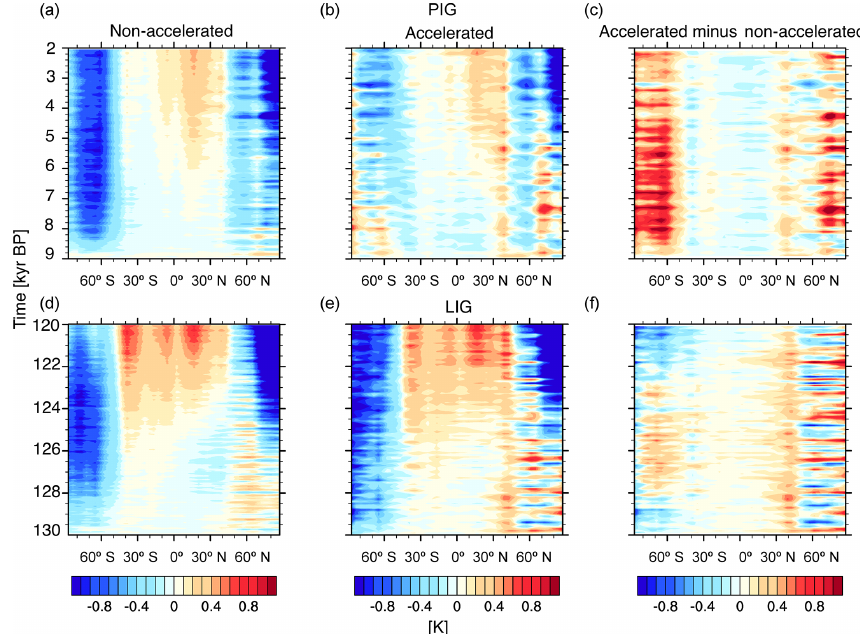
Figure 3. Evolution of zonally averaged surface temperature anomalies (including ocean and land) during interglacials for both non- accelerated (a, d) and accelerated (b, e) simulations. Shown are anomalies relative to 9kyrBP (PIG) and 130kyrBP (LIG). Differences in the temperature evolution between accelerated and non-accelerated simulations are also displayed (c, f) . All plots were created using the decadal mean values (referring to model years). In addition, a 10-point running average was applied to the decadal mean values of the non-accelerated simulations. See the main text (Sect. 2) for the calculation of differences (c, f)